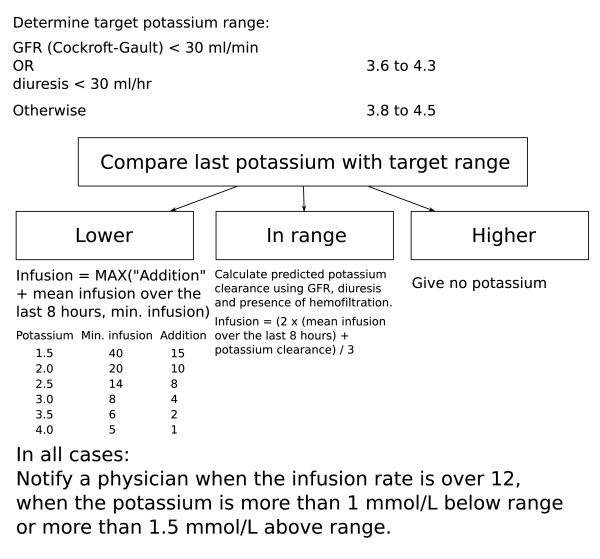
Diagram of the GRIP-II potassium algorithm. A schematic diagram of the potassium infusion recommendation algorithm of GRIP-II. Note that the exact source code to the algorithm is freely downloadable from the project web site http://grip-glucose.sf.net/.